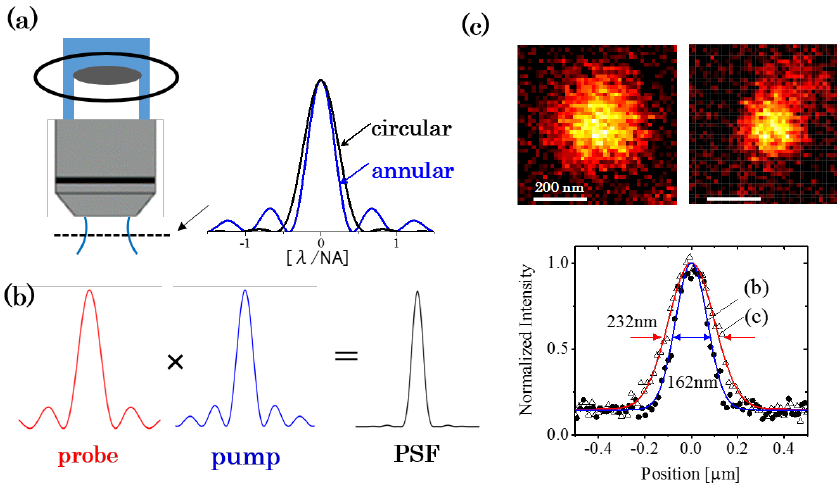
Figure 5. Photothermal images of a slice of mouse melanoma in the ( a ) lateral and ( b ) axial planes. ( c ) 3D rendering of a set of 30 image slices. Image size is 19.6 × 19.6 × 8.2 μm 3 .